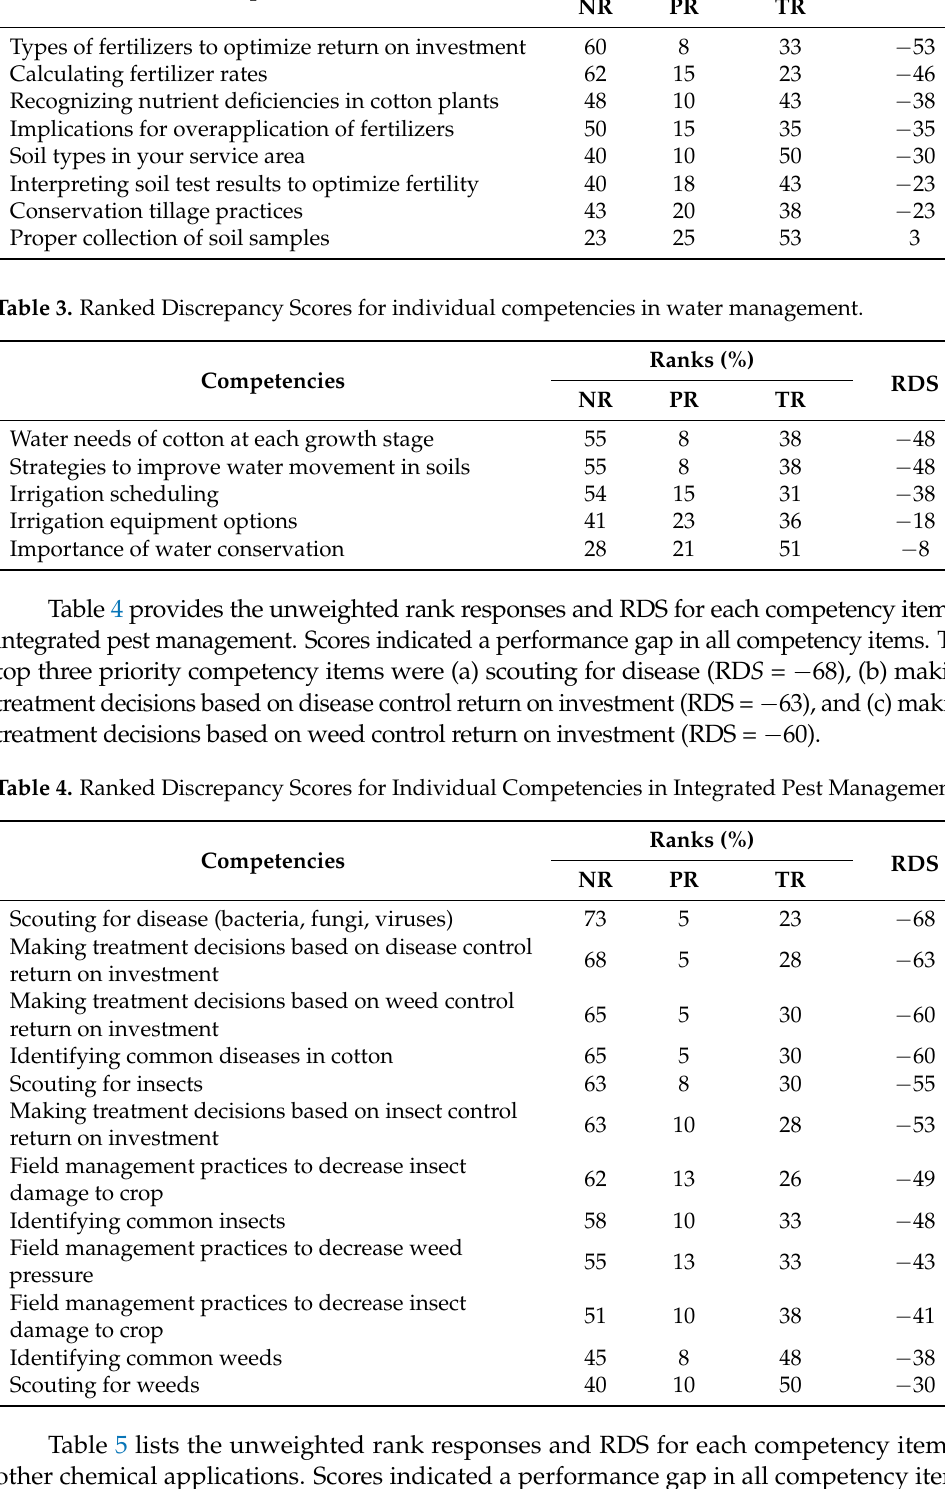
Table 2. Ranked Discrepancy Scores for individual competencies in soil and nutrient management. Competencies